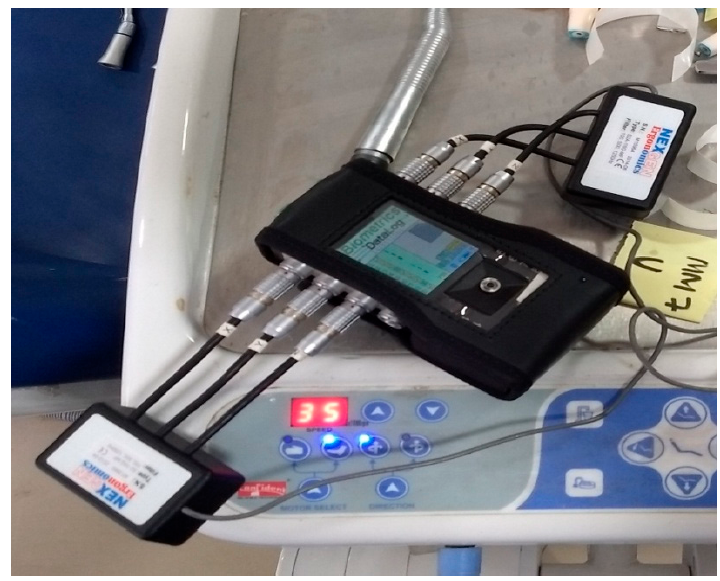
Figure 3. Data-logger with an accelerometer.